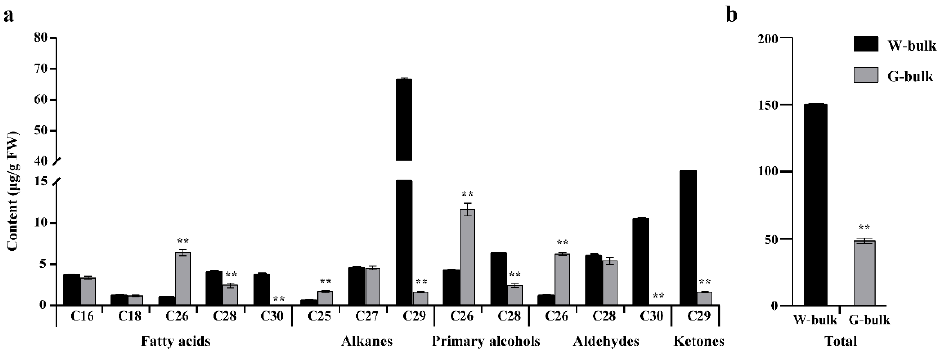
Figure 2. Cuticular wax composition in leaves from W-bulk and G-bulk. ( a ) Wax composition of W-bulk and G-bulk. ( b ) Total wax load of W-bulk and G-bulk. Error bars indicate SD (n = 3). ** p -value < 0.01.